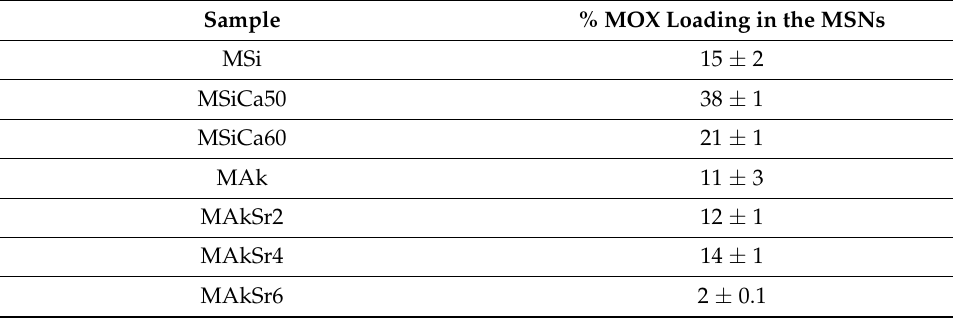
Table 3. Moxifloxacin drug loading (%) into the MSNs.